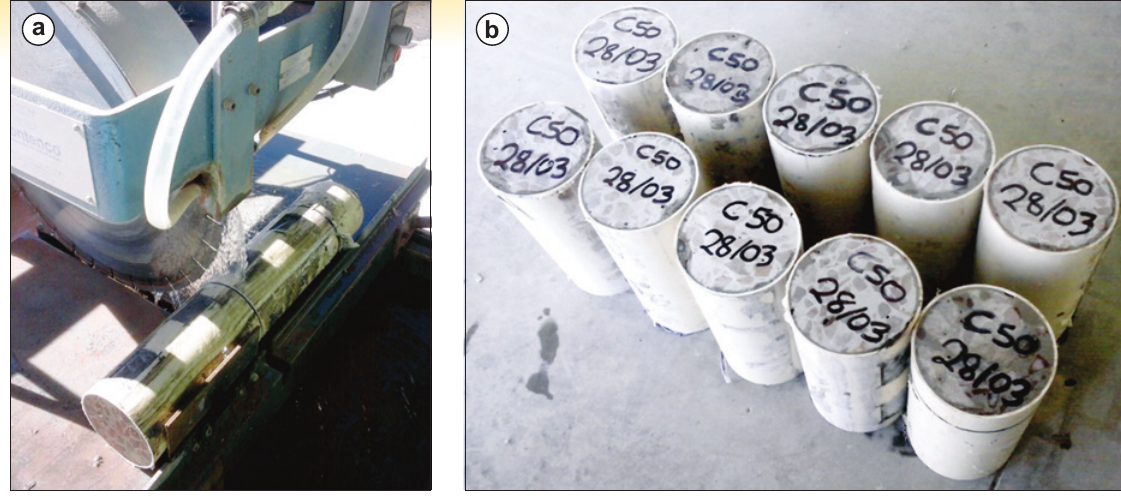
(a) Circular saw, (b) Samples cast with cylinder axes in horizontal position